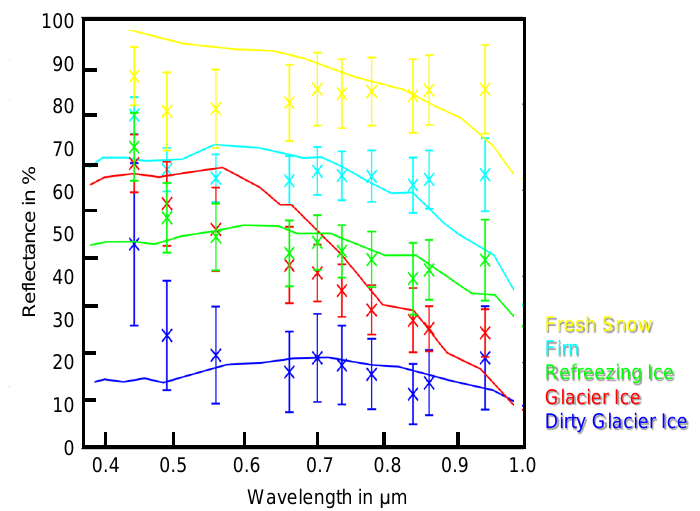
Figure 5. Combined plot for comparison of theoretical spectral reflectance curve (cf. [10]) and mean/standard deviation of reflectance values of the created dataset per band per class, the latter being displayed for each band’s central